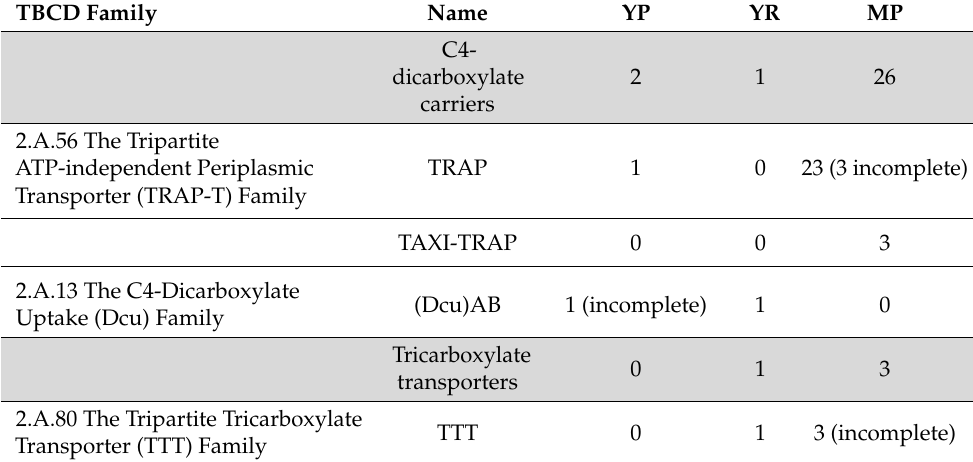
Table 4. Carboxylate transporters in the studied